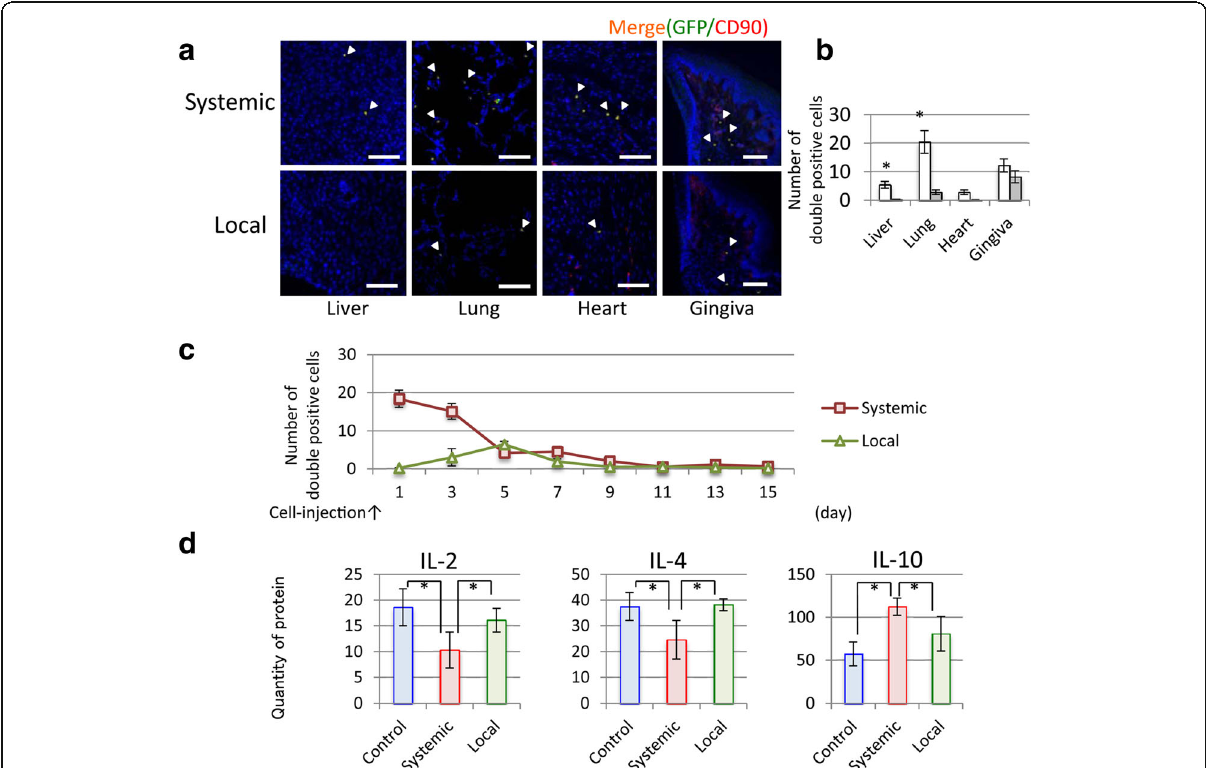
Fig. 4 Whole body accumulation of MSCs. a CD-90/GFP-FITC double-positive cell (white arrowhead) visualization at day 1. (Bar=200 μ m) ( b ) CD-90/ GFP-FITC double-positive cell counts in various organs in the control, systemic (white), and local (gray) groups at day 1. c Change of intravascular MSCs number up to 14 days after systemic or local MSC injection. d Levels of serum inflammatory cytokines, IL-2, IL-4, and IL-10 in control, local, and systemic